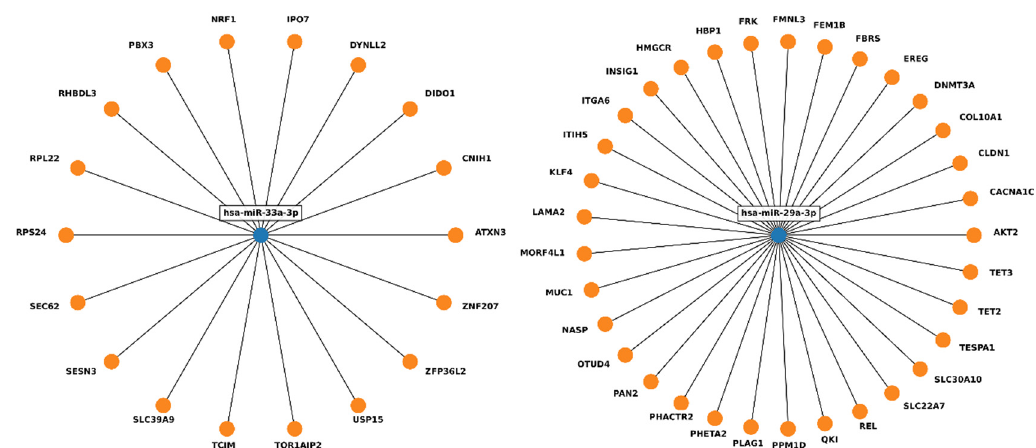
Figure 4. Experimentally validated targets of miR-33a-3p and miR-29a-3p, found by miRWalk in miRTarBase.